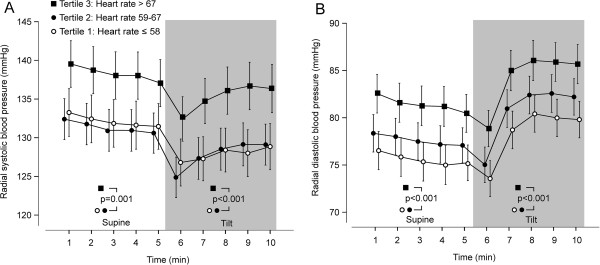
Radial blood pressures during rest and passive head-up tilt according to resting heart rate tertiles. (A) Systolic blood pressure, (B) diastolic blood pressure; mean (95% confidence intervals), p values denote significant differences between the tertiles depicted with different symbols.